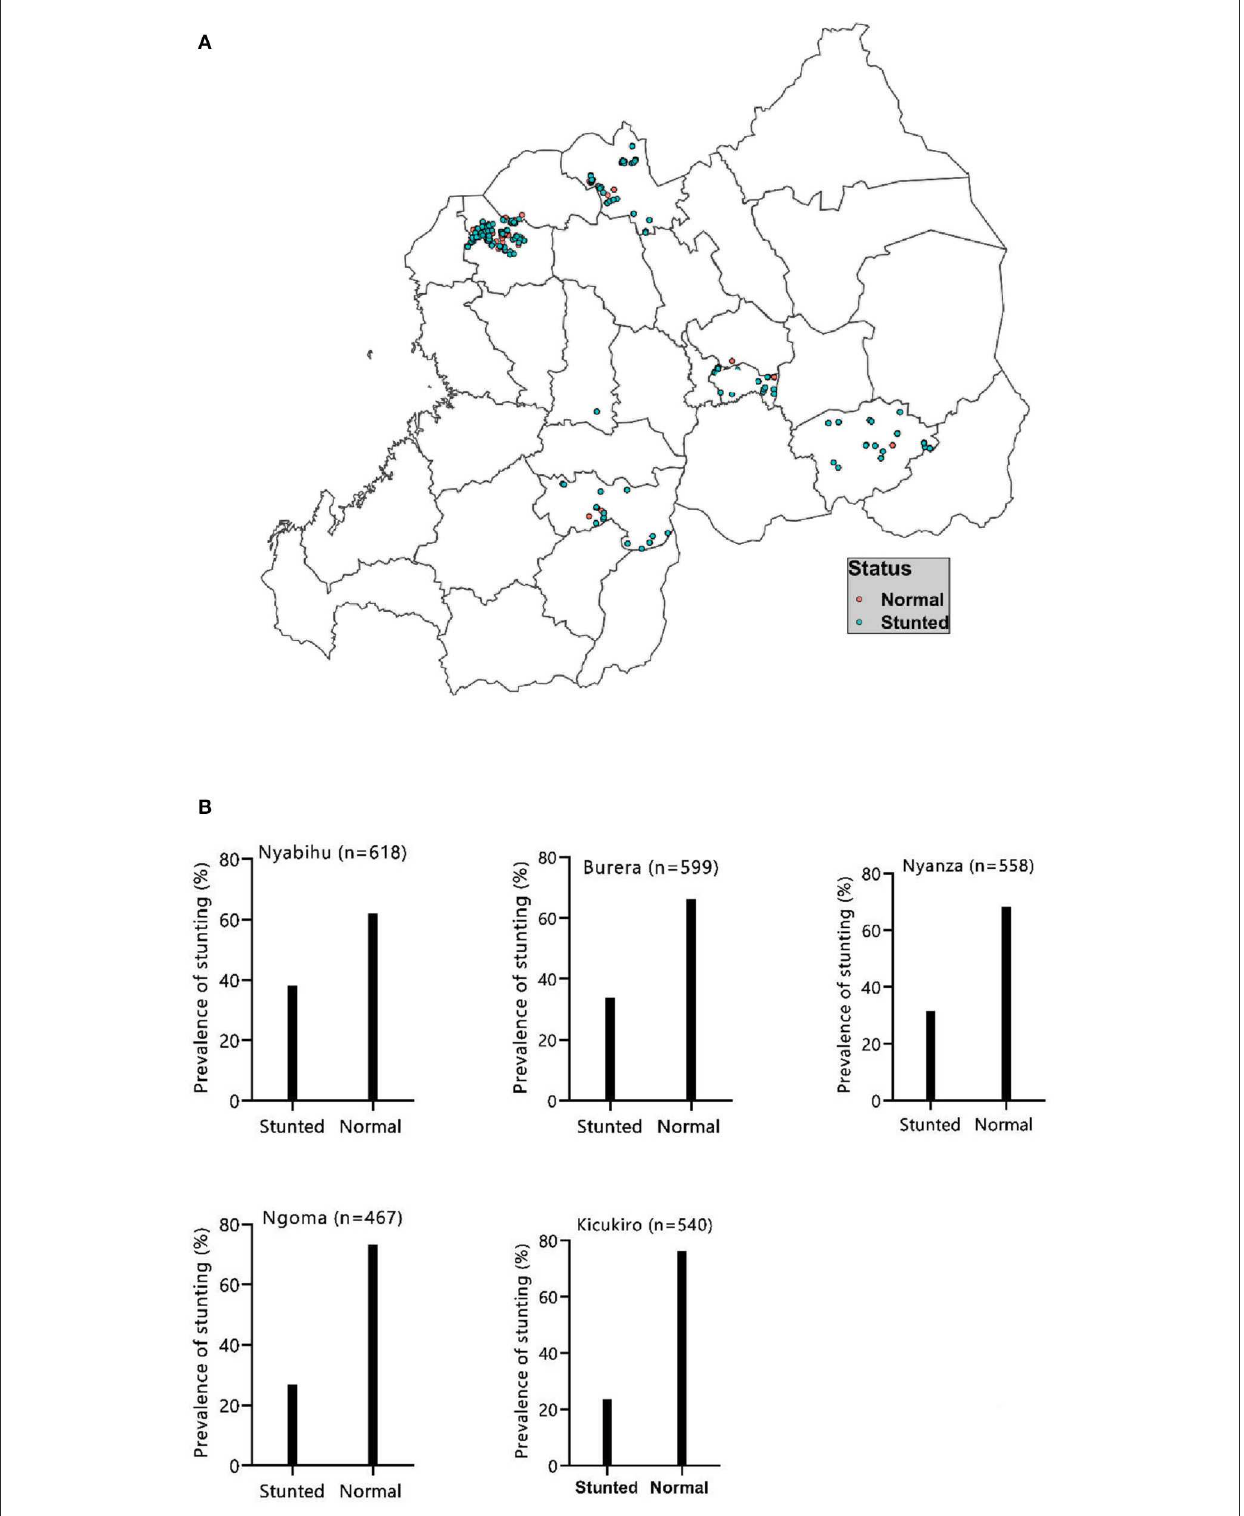
FIGURE2 Distribution (A) and proportion (B) of childhood stunting in the study